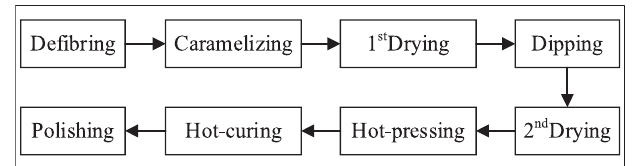
FIGURE 1 | Production of bamboo